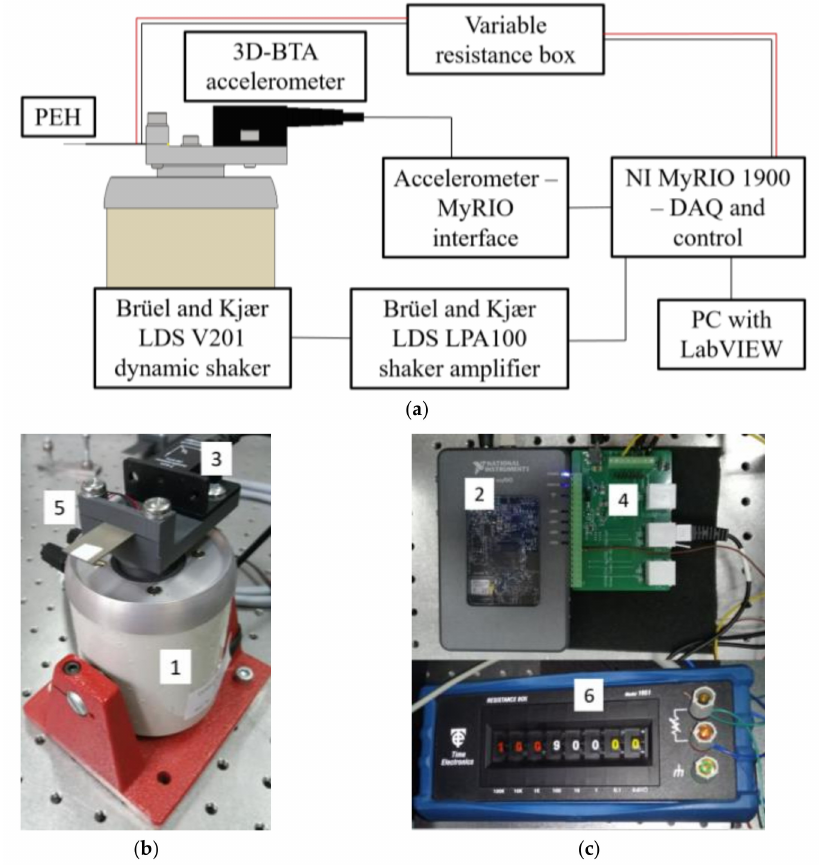
Figure 6. Schema of the experimental setup for harmonic analyses ( a ) with the actual execution showing the Brüel and Kjær ® shaker with the accelerometer and the bimorph harvester [38] ( b ), as well as the control, DAQ and variable resistor units [38] ( c